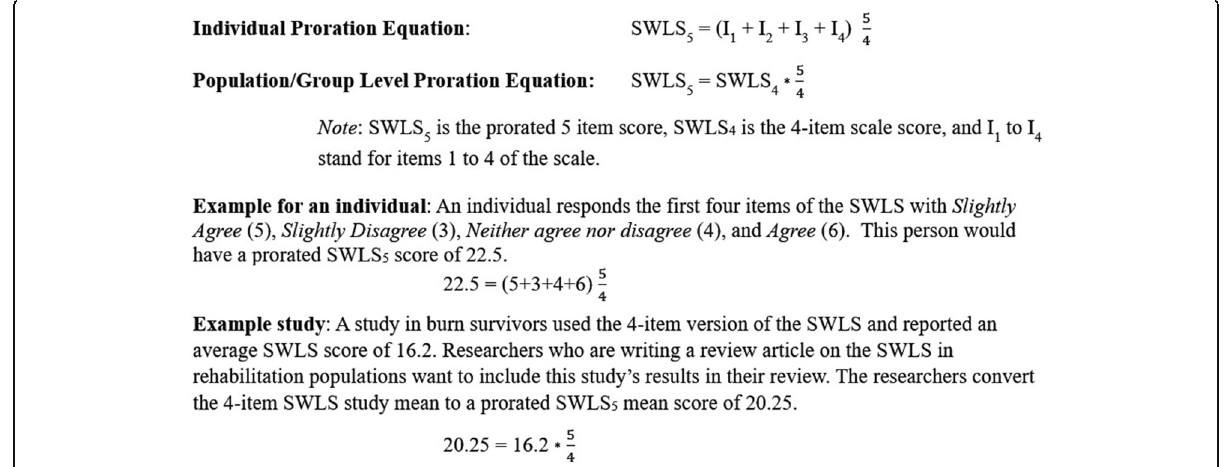
Fig. 2 Equations and examples of how to implement the recommended proration technique at both the individual and group